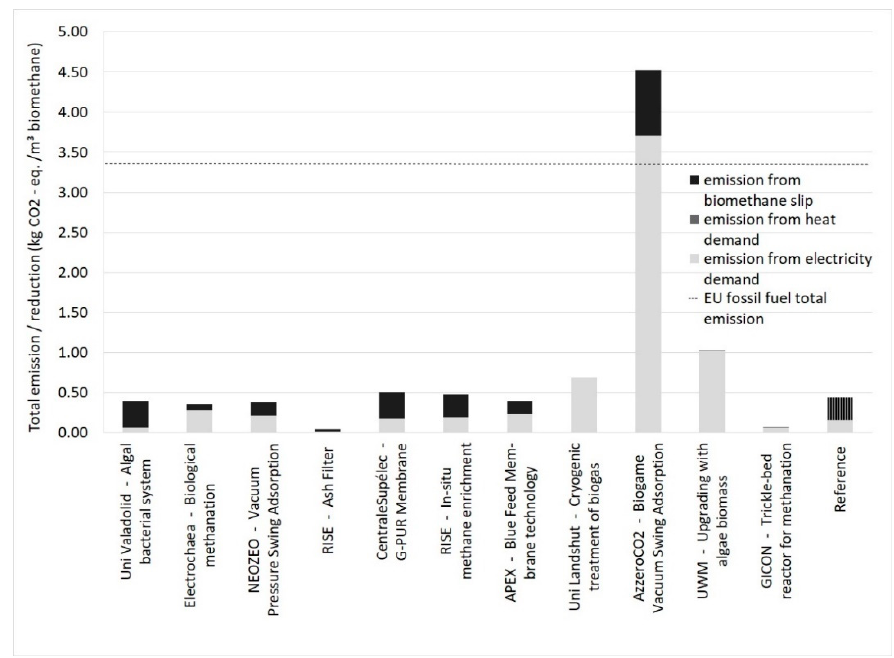
Figure 8. GHG emissions for upgrading technologies and EU fossil fuel comparator for natural gas used as biofuel.